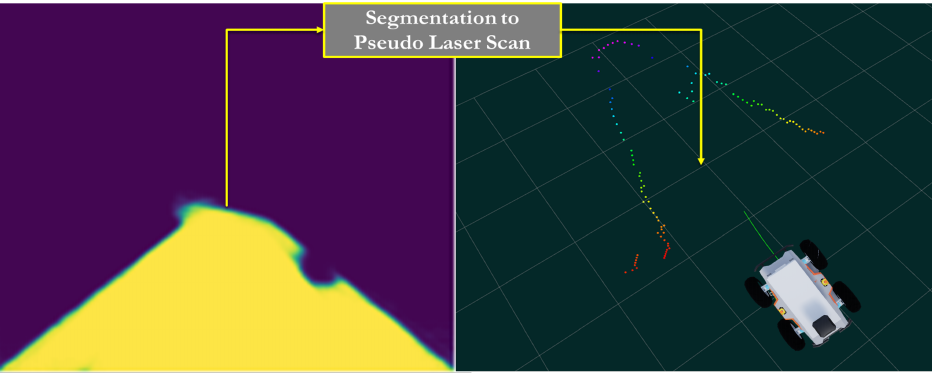
Figure 4. From semantic segmentation to pseudo laser